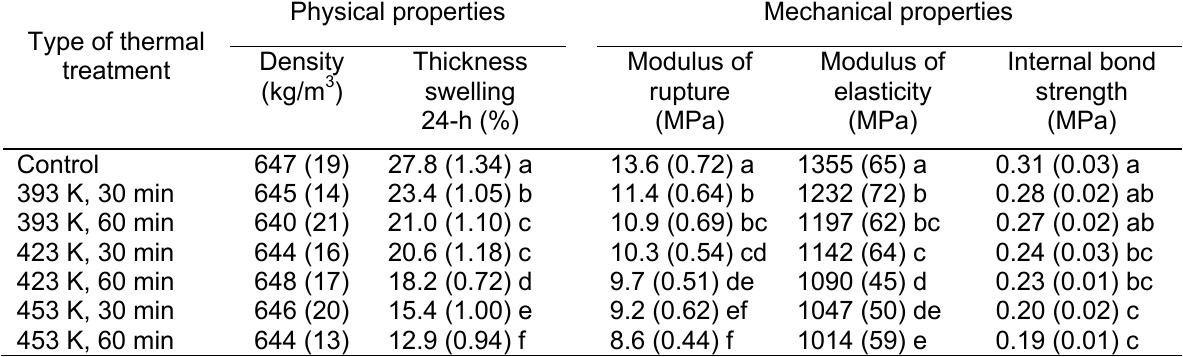
Table 1. Groups with same letters in column indicate that there is no statistical difference ( p < 0:01 ) between the sam- ples according Duncan’s multiply range test; values in parentheses are standard deviations.